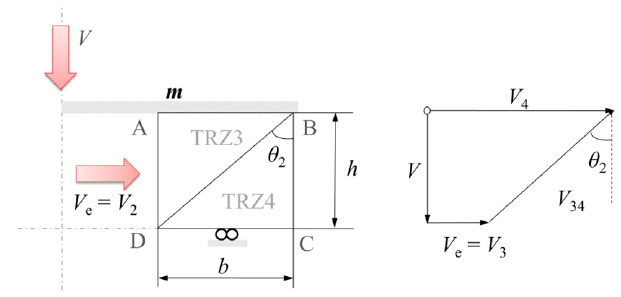
Figure 8. Module B (MB) approach.